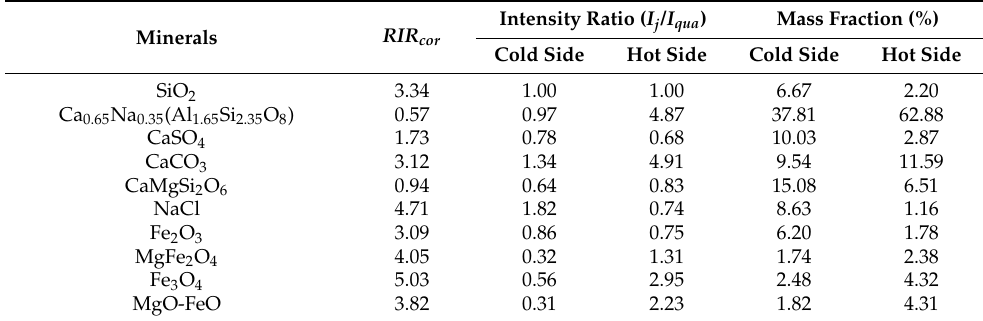
Table 1. Quantitative results of main minerals in the slagging samples collected from the middle and rear sections of rotary kilns.